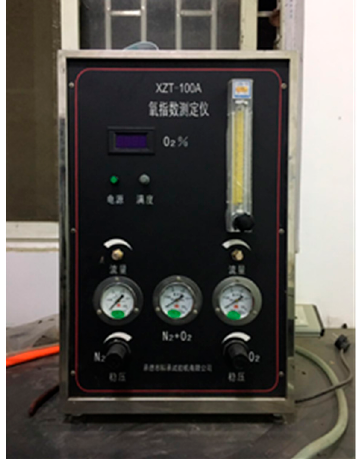
Figure 1. Apparatus for oxygen index test.